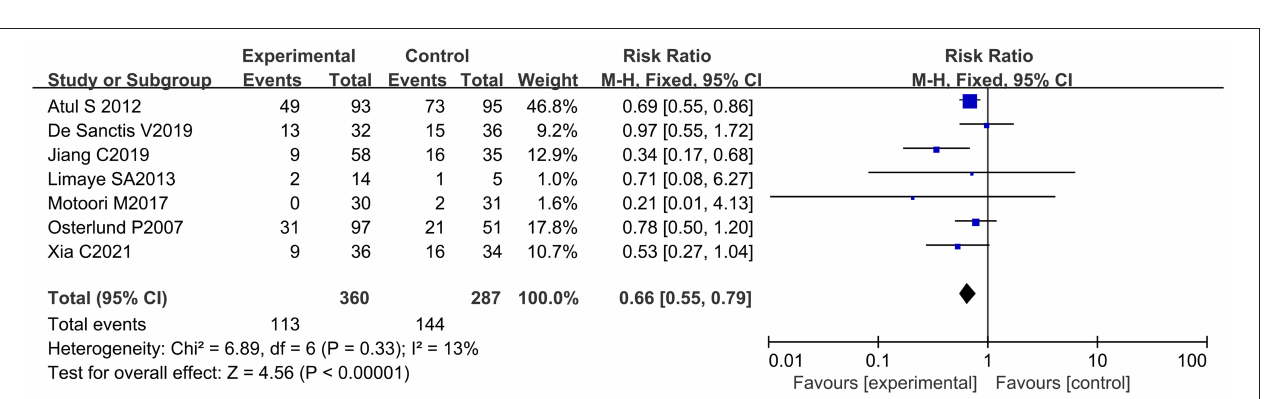
FIGURE 7 | Forest plot of oral probiotic use for reducing oral mucositis in cancer patients.